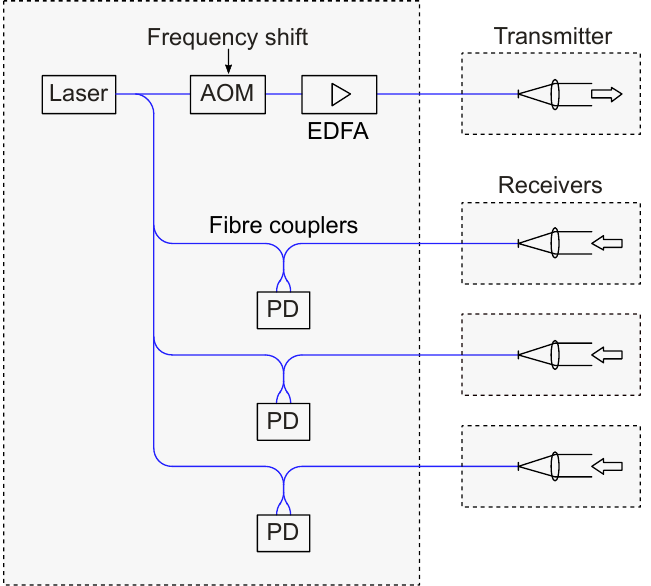
Figure 5. The optical set-up is constructed using fibre optics. A narrow-bandwidth laser reference is modulated, amplified and fed into the transmitter beam optics. The light scattered back into the receiving beam optics is fed into fibre couplers, where it is coherently mixed with the reference laser’s light. Each optical mixing product is fed into a balanced photodetector, where it is converted to an electrical